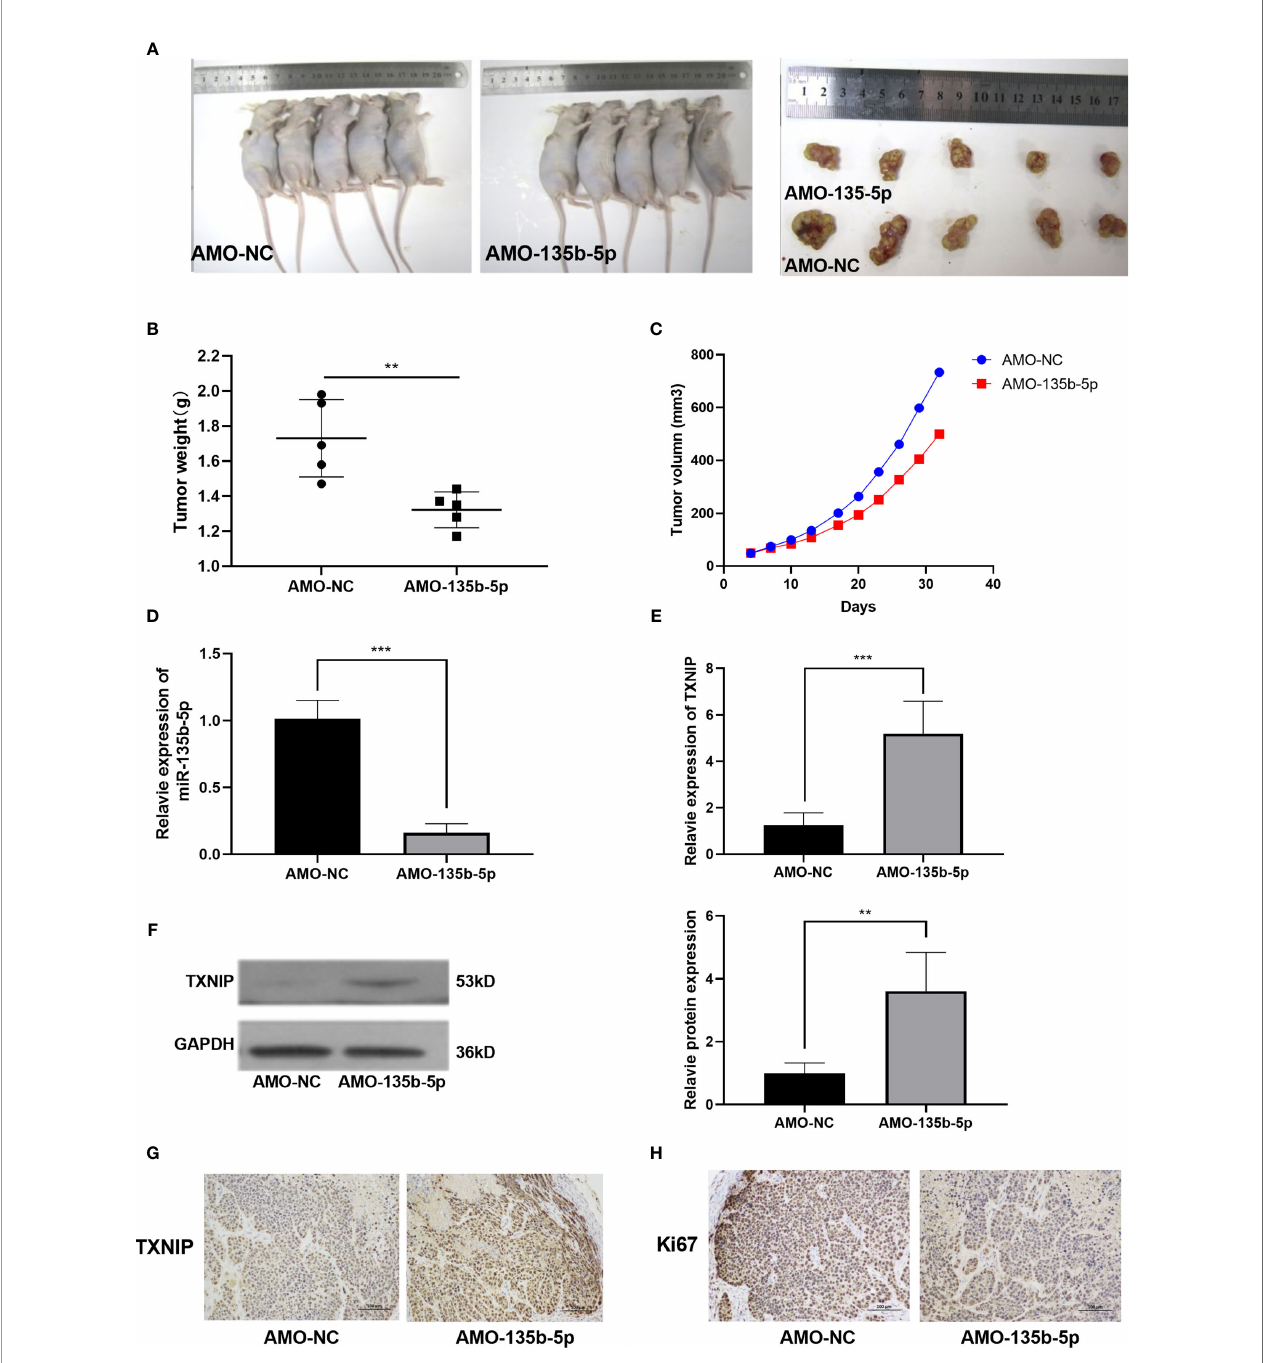
FIGURE 5 | MiR-135b-5pinhibitionsuppressedthegrowthofEC invivo . (A) Xenograftmicetumormodelimagesonthe30thdayoftreatment. (B) Thesizeofthetumorswas smallerinthemiR-135b-5pinhibitiongroupcomparedwiththenegativecontrolgroup. (C) Thetumorgrowthcurvewasrecorded. (D,E)